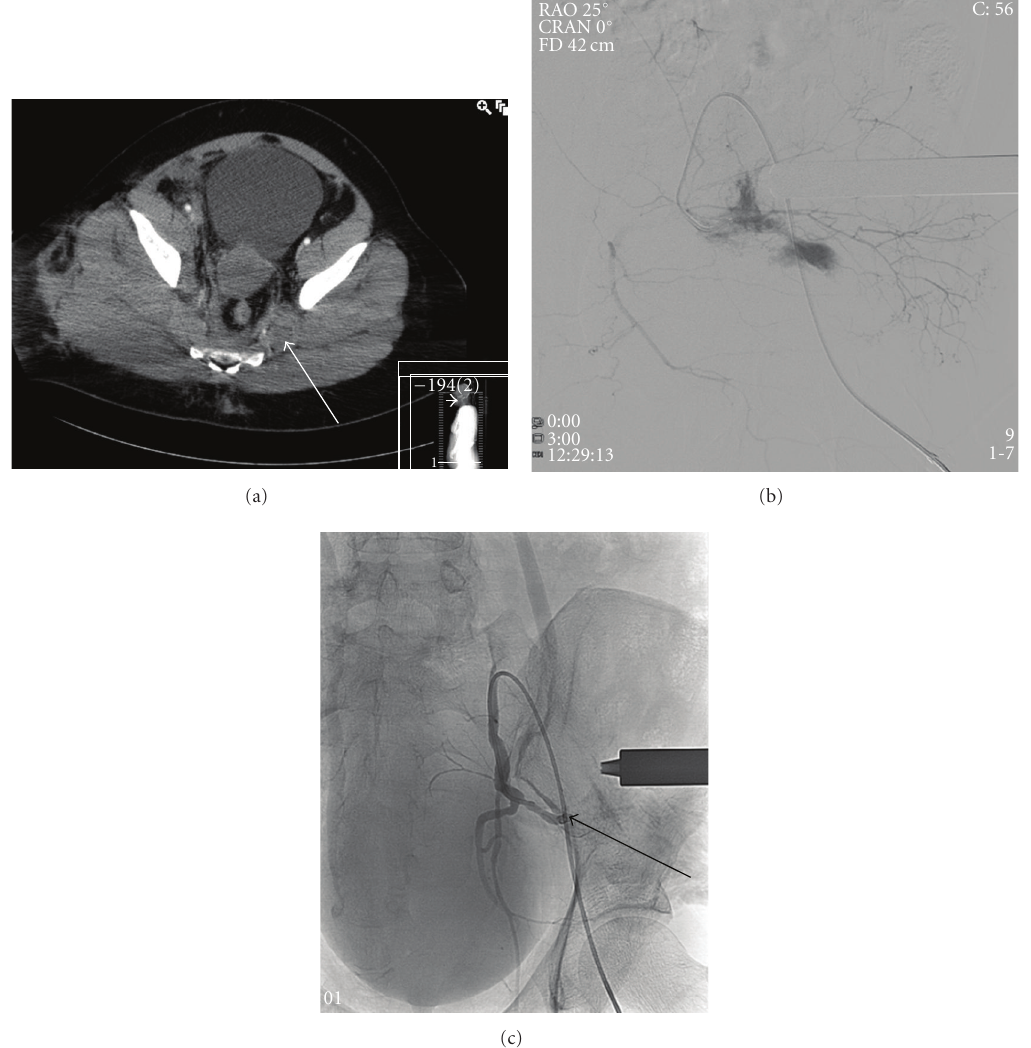
Figure 1: (a) Contrast-enhanced CT scan of a patient with a type C pelvic fracture after trauma. The arrow indicating a hematoma. (b) Selective catheterization of a branch from the left internal iliac artery showing a contrast blush, indicating an active bleeding. (c) Catheterization of the left internal iliac artery after coil embolization of the actively bleeding branch, with absence of any contrast blush (arrow indicating the coil in